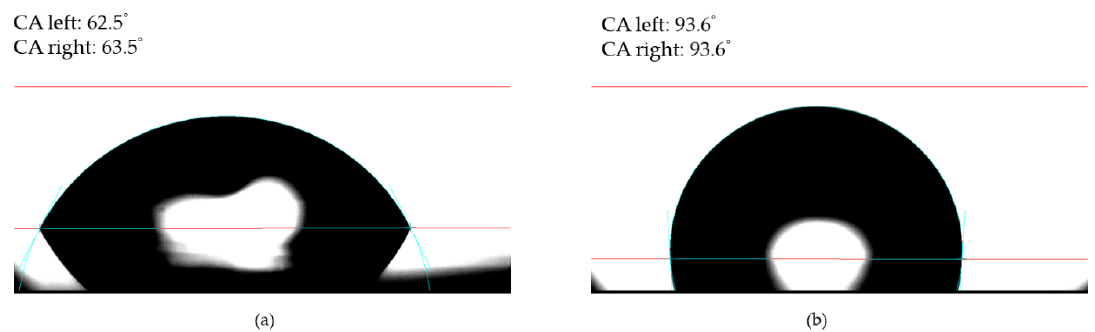
Figure 4. The images of water contact angle (wettability) measurement for ( a ) a coverslip and ( b ) TiO 2 on a coverslip (CA left indicates measured links’ contact angle, while CA right indicates measured right contact angle).